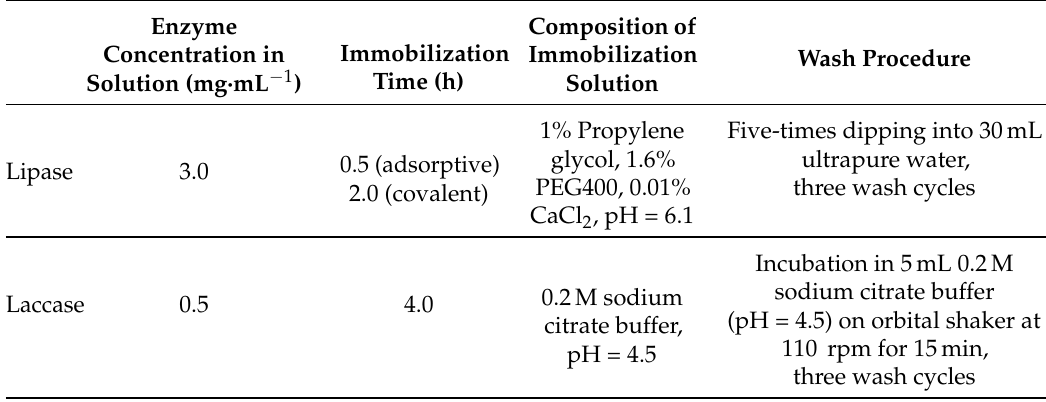
Table 4. Conditions for adsorptive and covalent immobilization of laccase and lipase on acid-pretreated BT or PEMA-BT,